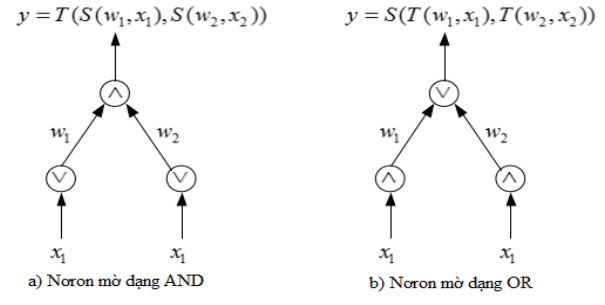
Figure 6. The fuzzy neuron